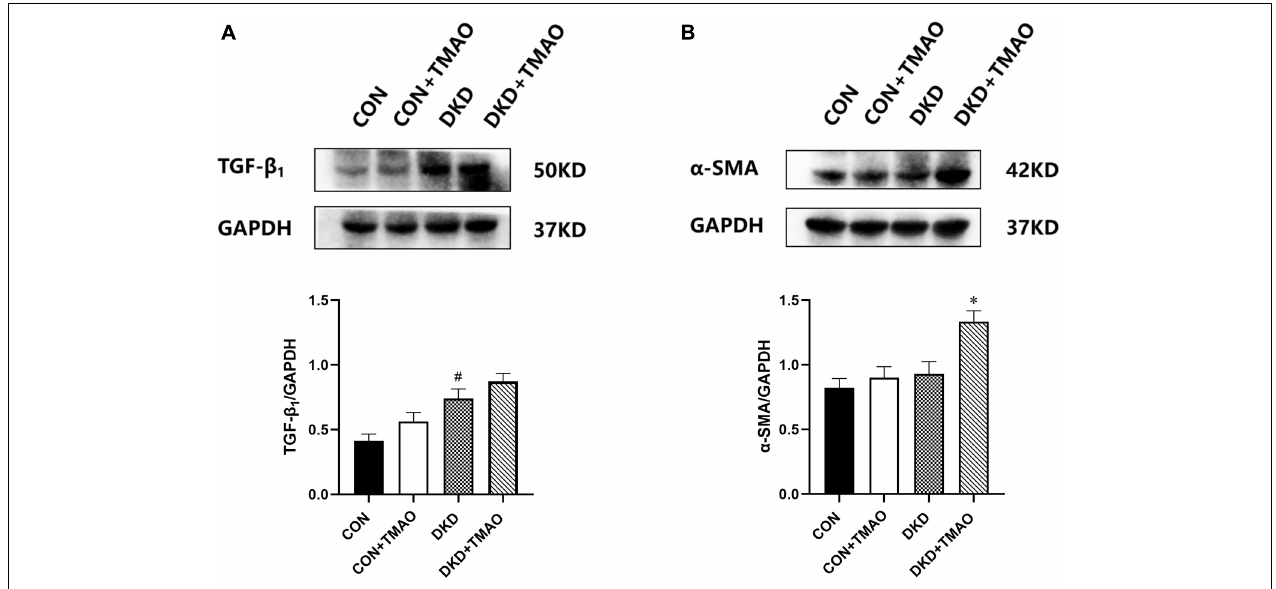
FIGURE 5 | Expression of renal fibrosis proteins in the kidney of rats. (A) TGF- β 1 protein levels. (B) α -SMA protein levels. Data are presented as mean ± SEM ( n > 3 for each group). # P < 0.05 vs. CON, ∗ P < 0.05 vs.